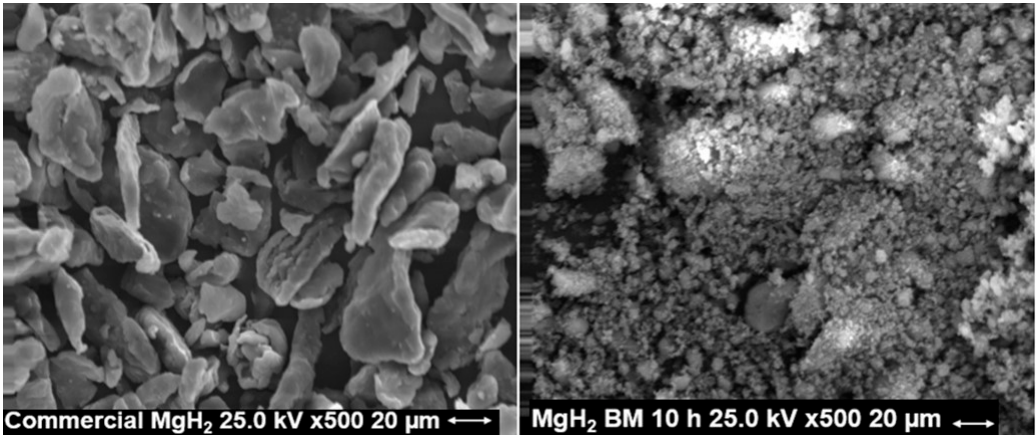
Figure 5. SEM of (left) commercial bulk MgH 2 and (right) micro / nanocrystalline MgH 2 prepared via mechanical pulverization for at least 10 h.